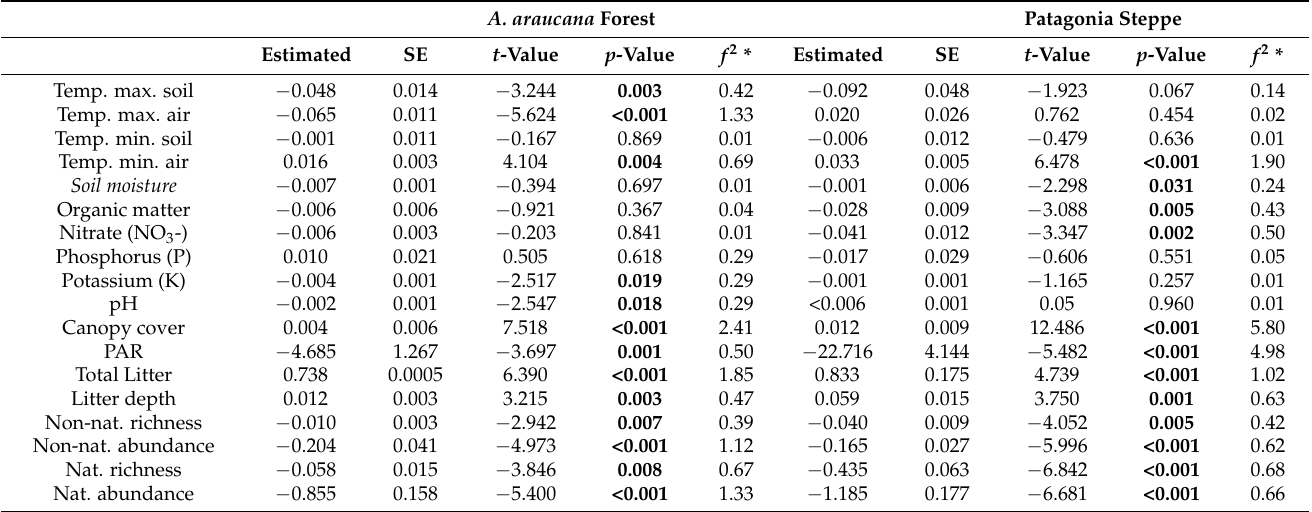
Table 1. Estimated parameters, standard errors (SE), t -values, p -values, and Cohen’s coefficients for effect size ( f 2 ) for the models of both sites for all variables measured as a function of P. contorta biomass. Significant p -values are marked in bold ( p -value < 0.05).